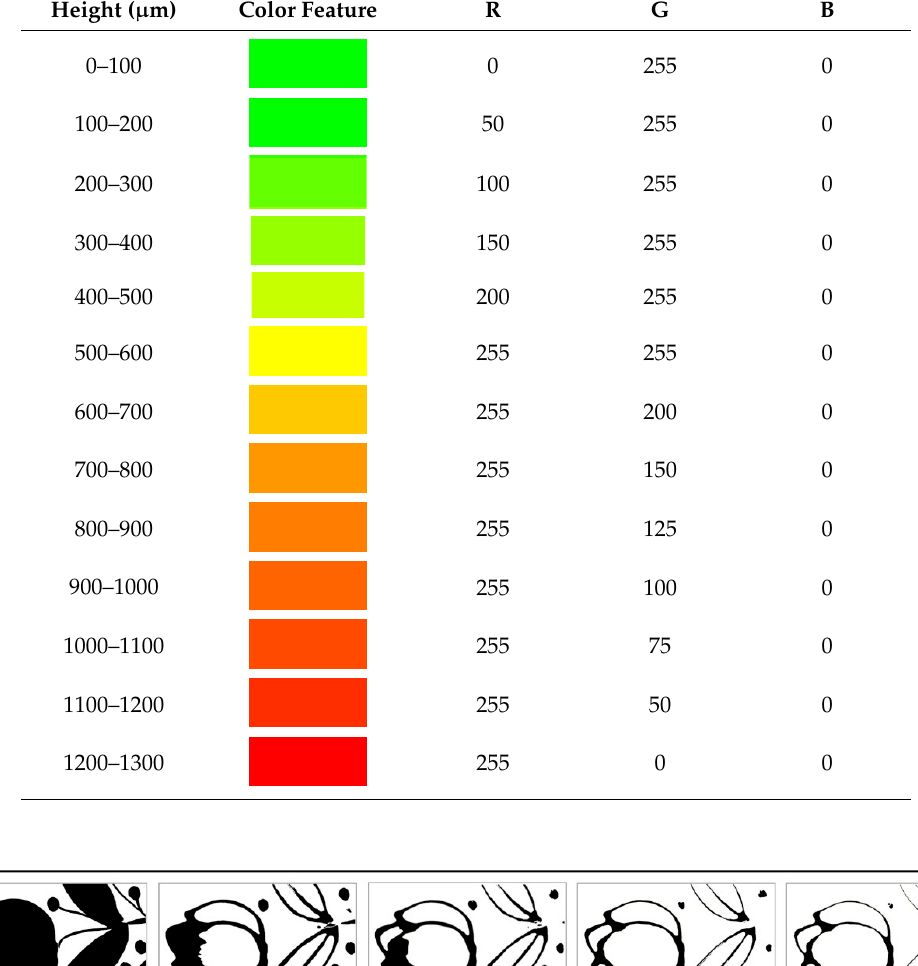
Table 1. Coloring feature of each layer contour for an oil painting model.